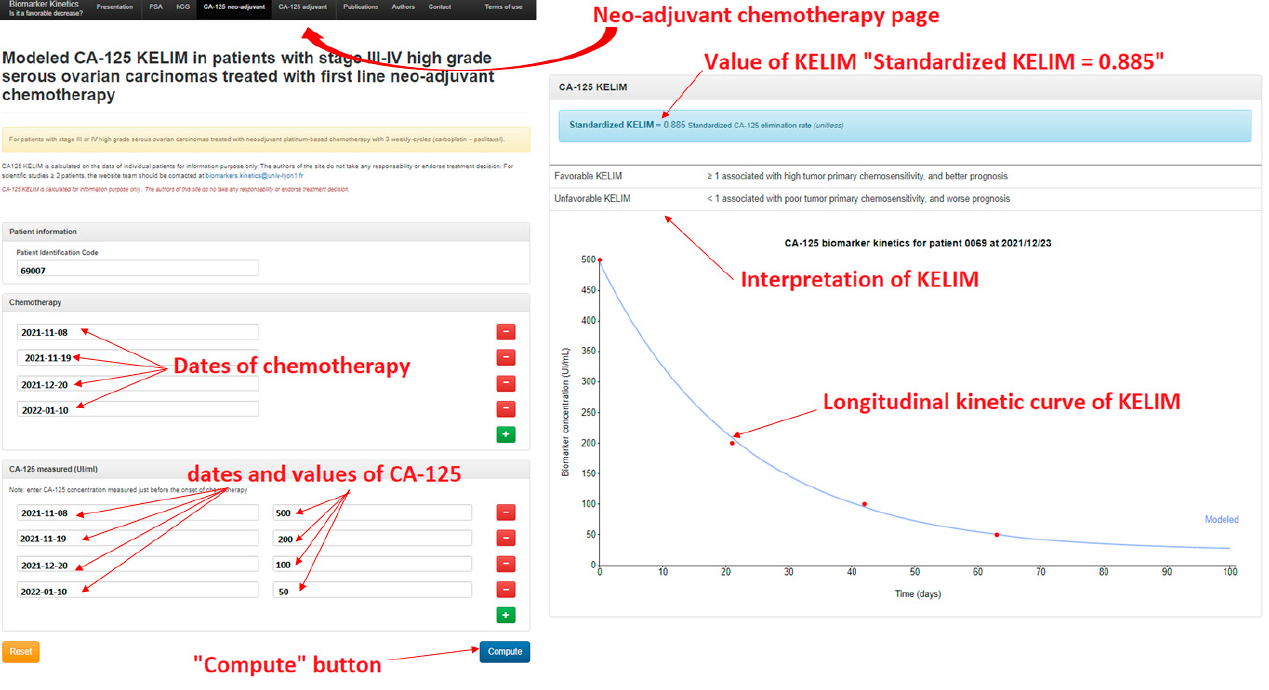
Figure 5. Illustration of the site http://www.biomarker-kinetics.org/CA-125-neo (accessed on 24 De- cember 2021) for calculating KELIM in a patients treated with neo-adjuvant chemotherapy.